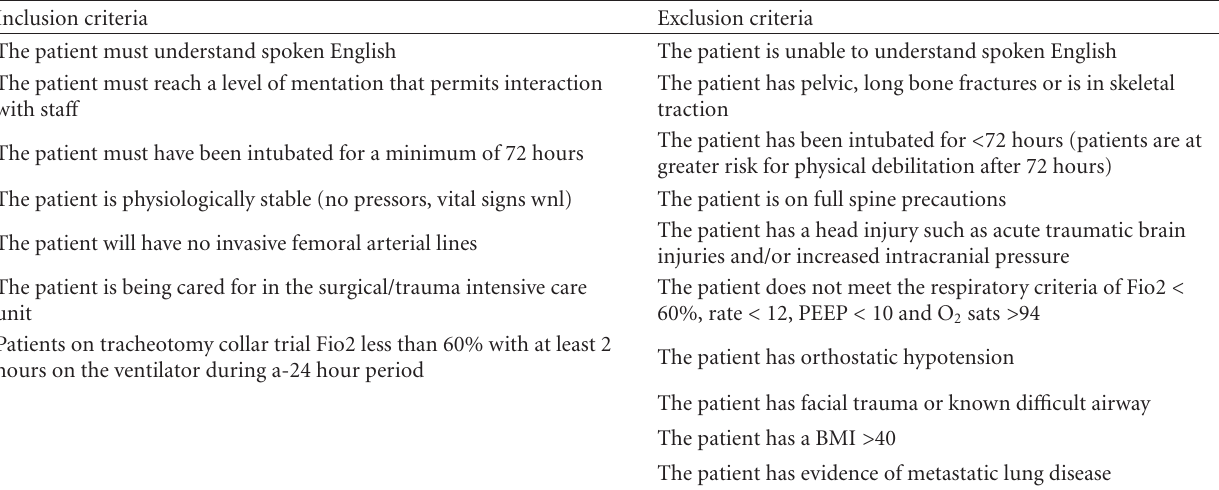
Table 1: Inclusion/exclusion criteria for pilot study.